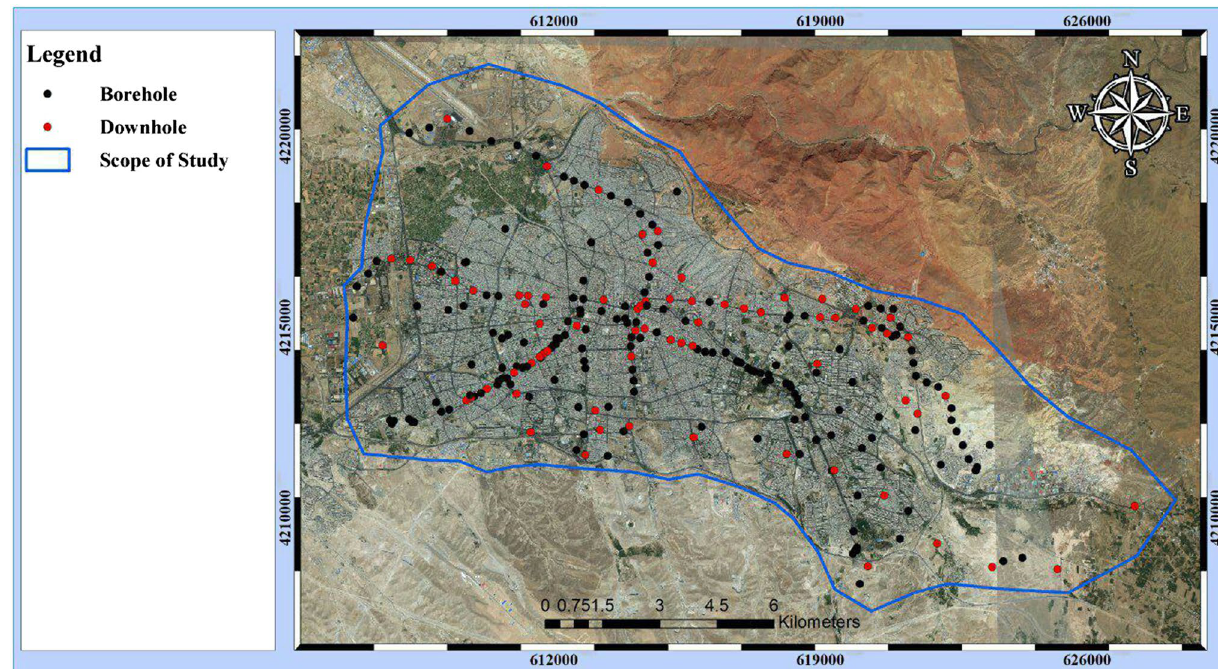
Fig. 6 Distribution of collected data for seismic